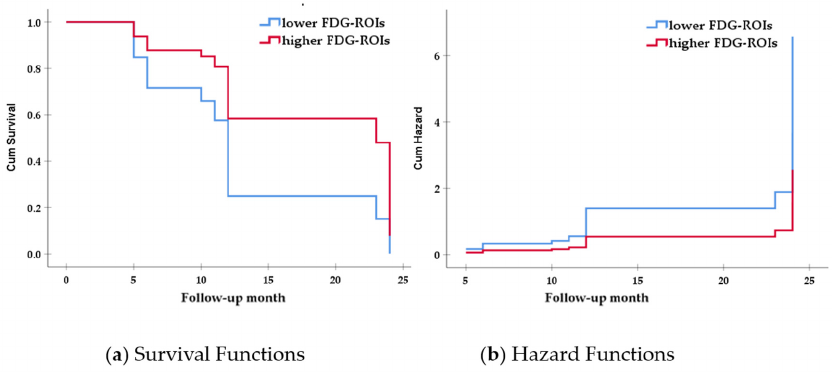
Figure 1. Survival and hazard functions for FDG-ROIs in the larger ICV group. Note: ( a ) survival functions; ( b ) hazard functions; red line: higher FDG-ROIs group. Blue line: lower FDG-ROIs group; FDG-ROIs = [ 18 F] fluorodeoxyglucose positron emission tomography regions of interest, including the bilateral inferior temporal, lateral parietal, and bilateral posterior cingulate cortex regions.